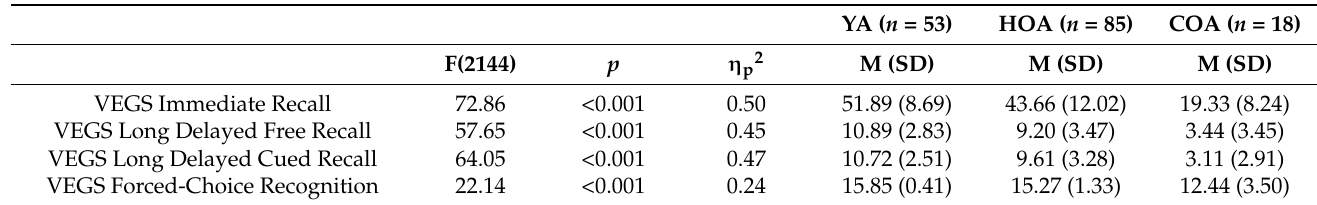
Table 1. Univariate group differences between subtests and descriptive statistics on the VEGS variables ( N = 156) with education as a covariate.